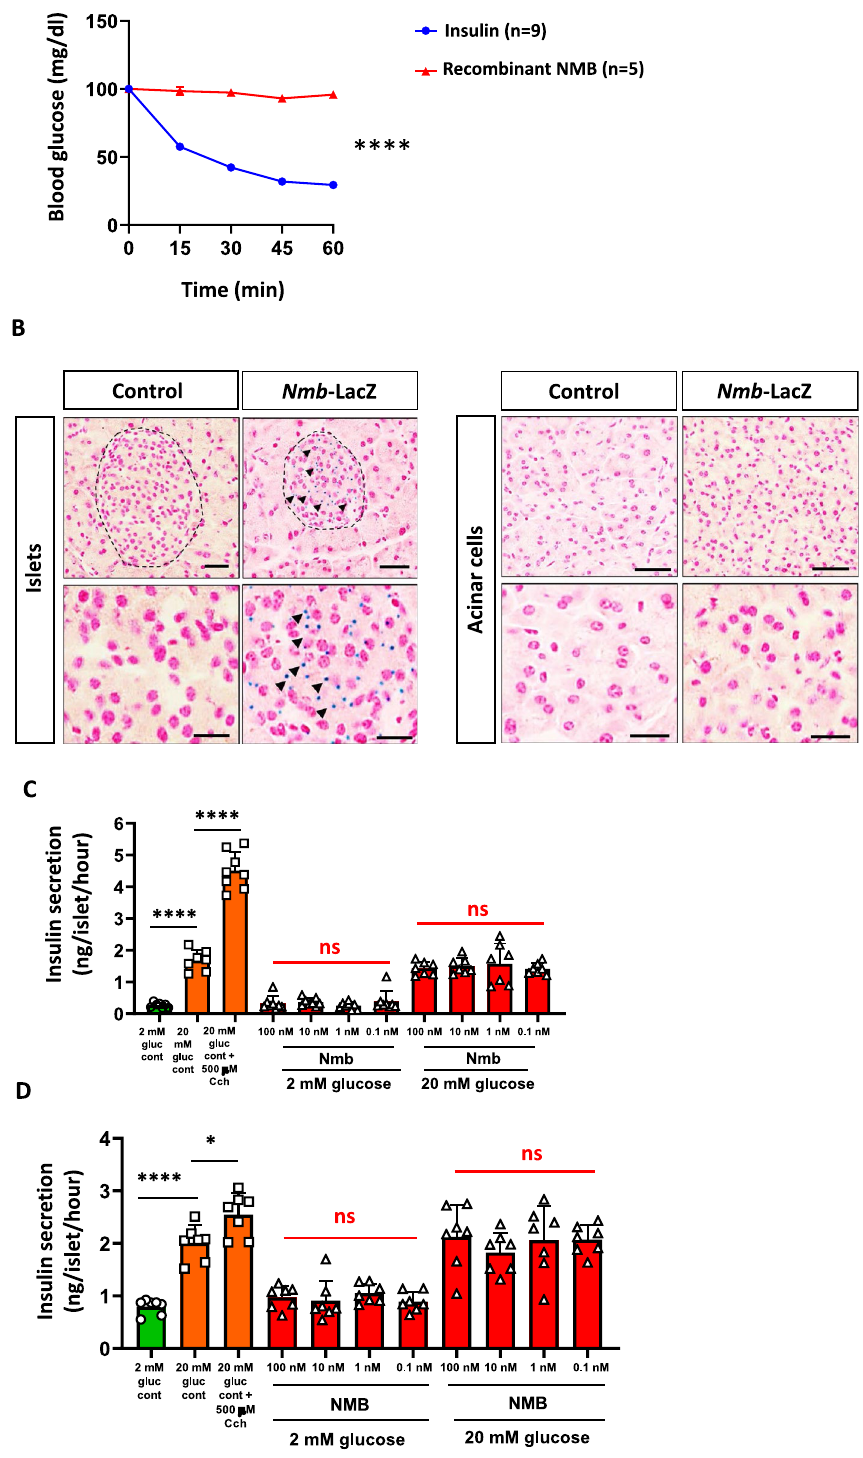
Figure 4. NMB does not affect systematic glucose metabolism neither acts as an insulin-releasing peptide in mouse and human islets. ( A) Blood glucose levels after i.p. insulin and recombinant NMB injection. n = 5–9 mice per group. ( B) LacZ staining of pancreas isolated from control and Nmb LacZ reporter mice. Representative staining of two mice are shown. ( C) Insulin secretion upon increasing glucose, carbachol or NMB concentration of isolated mouse islets. Each dot represents a group containing 5 islets. ( D) Insulin secretion upon increasing glucose, carbachol or NMB concentration of isolated human islets. Each dot represents a group containing 5 islets. Data are shown as means ± SEM. Each dot represents individual mice. * p < 0.05, ** p < 0.01, *** p < 0.001, and **** p < 0.0001, ns. not significant. For curve comparison, two-way ANOVA with repeated measures (Bonferroni correction) was used, otherwise unpaired Student t-test was used to determine statistical